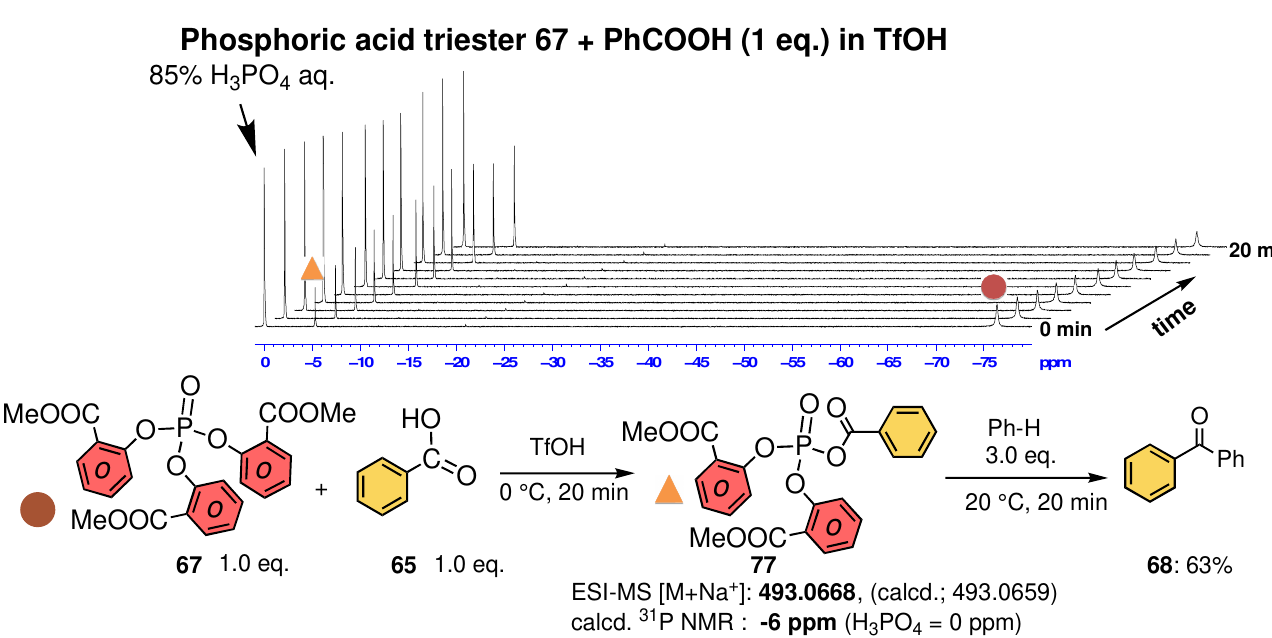
Scheme 21. Two possible pathways leading to P–O bond formation of carboxylic